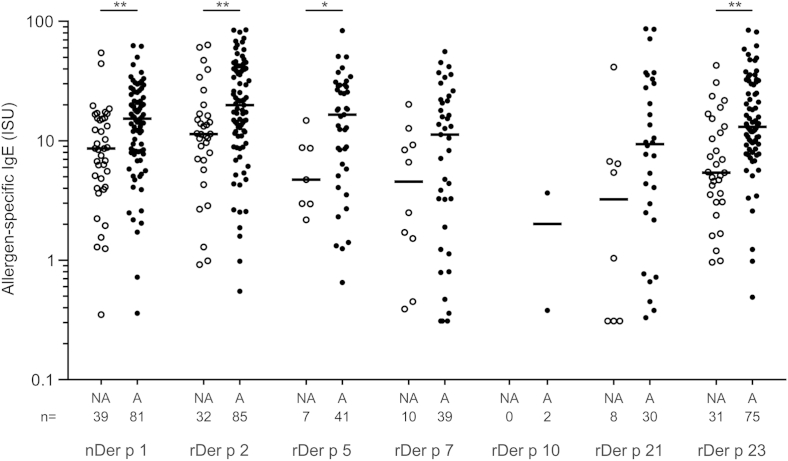
IgE levels to individual HDM allergens. Specific IgE levels (in ISU, y-axis) to HDM allergens (x-axis) determined for reactive children with HDM allergy with (A, right columns) and without (NA, left columns) asthma are displayed as scatter plots. The number of IgE-positive sera for the individual allergens are displayed below. Statistically significant differences between the 2 groups are indicated. *P < .05 and **P < .01.